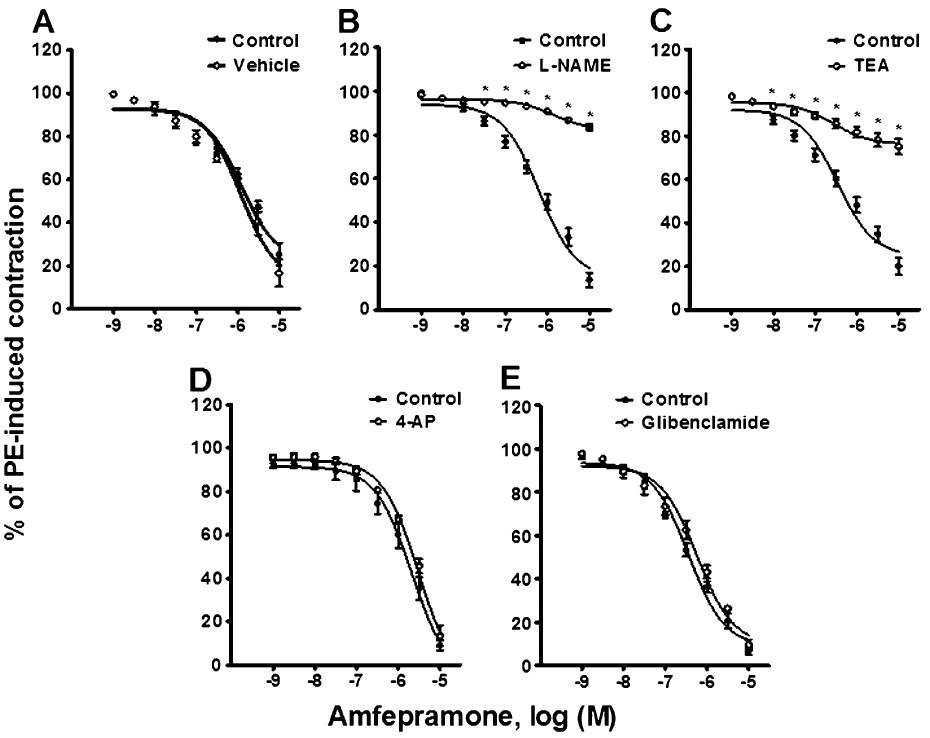
Figure 4. Amfepramone-induced vasorelaxation in rat aortic rings with functional endothelium and precontracted with 10 –6 M phenylephrine (PE). Effects of preincubation with: A , Vehicle (the distilled water control), B , 10 –5 M L-NG-nitroarginine methyl ester (L- NAME), C , 10 –2 M tetraethylammonium (TEA), D , 10 –3 M 4-aminopyridine (4-AP) and E , 3.1 6 10 –7 M glibenclamide. Data are reported as means±SE of n=6 observations. *P , 0.05 vs control (two-way repeated-measures ANOVA).